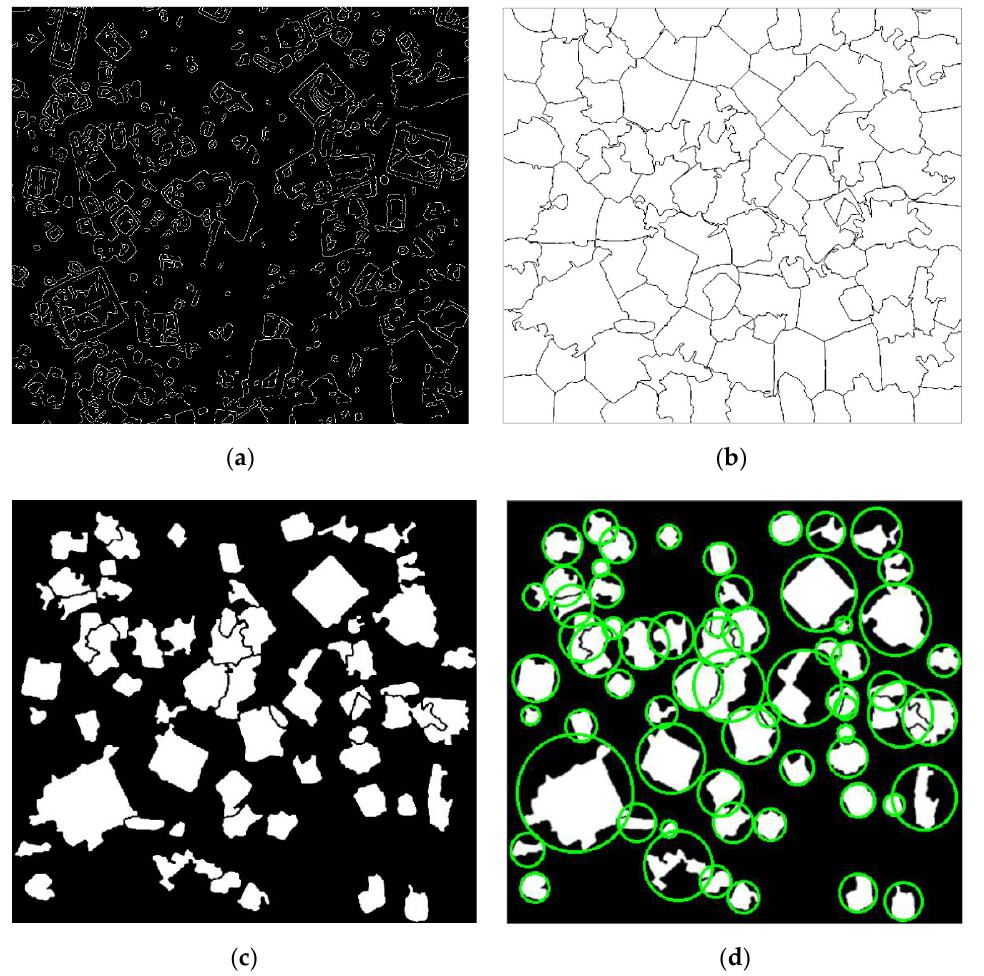
Figure 6. Segmentation results: ( a ) Canny edge detection; ( b ) SLIC segmentation; ( c ) fusion image; ( d ) size measurement.